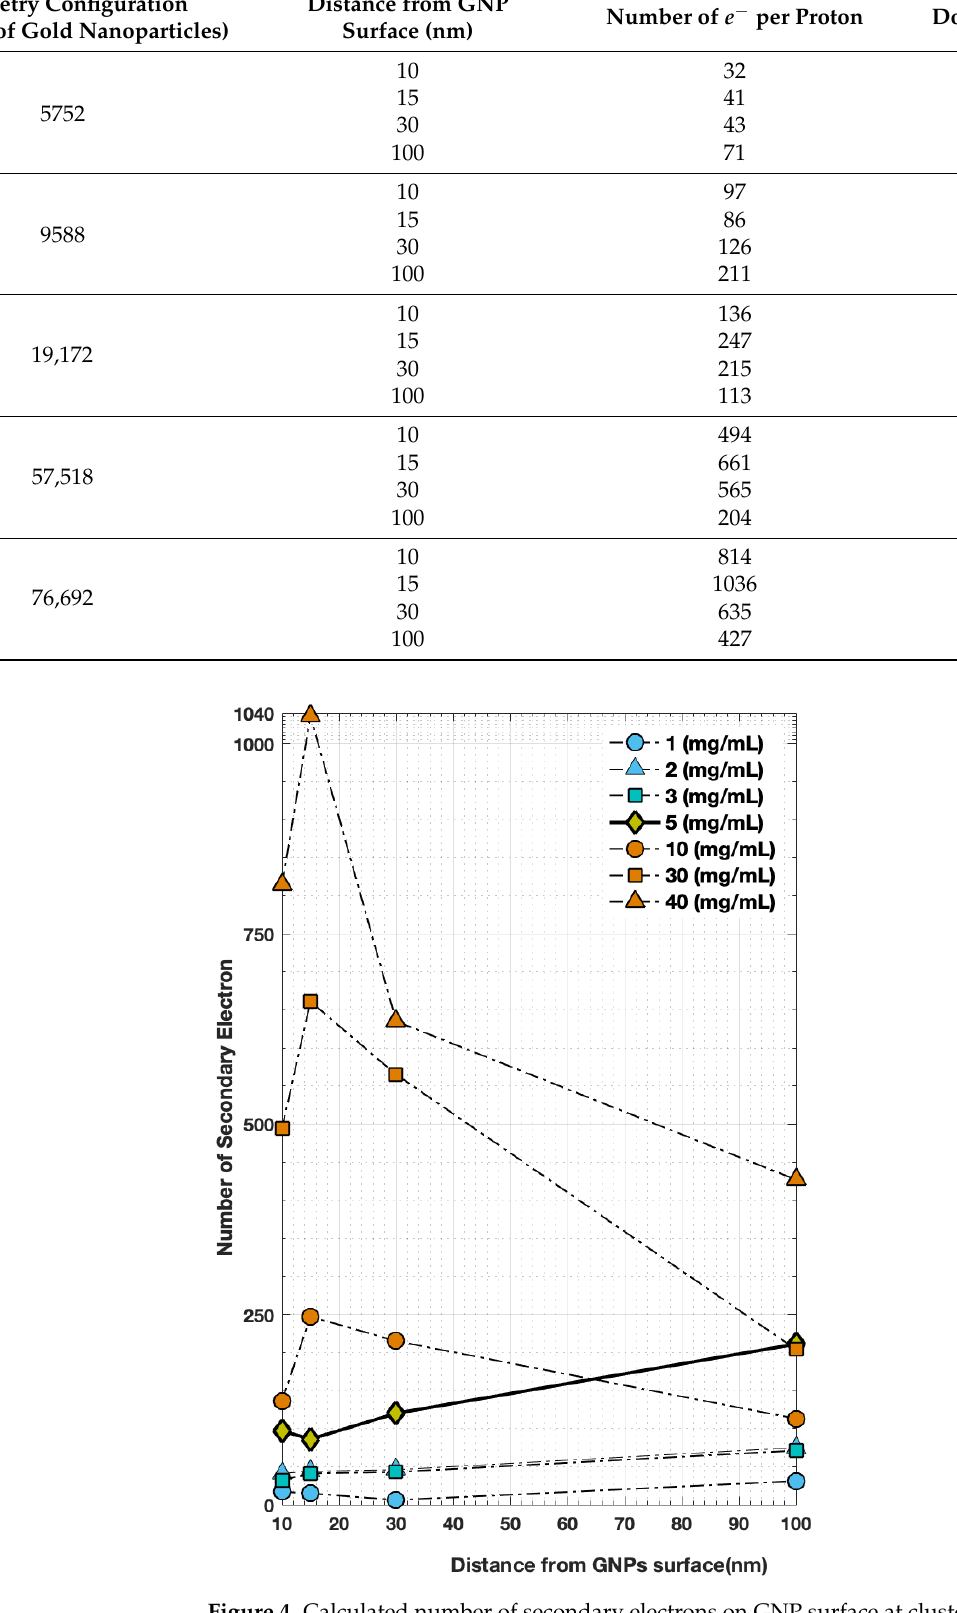
Figure 4. Calculated number of secondary electrons on GNP surface at cluster concentrations of 1, 2, 3, 5, 10, 30, and 40 mg/mL as a function of radial distance. In the case of concentrations of 1, 2, and 3 mg/mL, at a distance of 10 nm from the surface, the numbers of secondary electrons generated were approximately 17, 41, and 32, whereas at a distance of 15 nm, there were 15, 44, and 41; at 30 nm, there were 6, 46, and 43; and at 100 nm, there were 31, 75, and 71. A difference appeared at concentrations of 10, 30, and 40 mg/mL at a distance of 10 nm from the surface, with approximately 136, 494, and 814 secondary electrons generated, respectively, whereas at a distance of 15 nm, there were 247, 661, and 1036; at 30 nm, there were 215, 565, and 635; and at 100 nm, there were 113, 204, and 427, respectively. The largest change in electron generation appeared at concentrations of 10, 30, and 40 mg/mL; more significant changes were detected at the higher concentration, whereas they were relatively weaker compared with the lower con- centrations, as shown in Figure 4. Additional spherical water volume surrounding GNPs with different radii (10, 15, 30, and 100 nm) was added to determine the absorbed radiation dose in gray (Gy). This geometry was particularly useful for isolating the effect of electrons generated from the GNPs without any influence from the surroundings and comparing them to the reference material, which in this case was water. In other words, proton interactions could only take place in the gold or water if we wanted to record the energy deposition caused by second- ary electrons in this particular region. To achieve this, we counted the secondary electrons emitted from each GNP and then compared the results with the previously published values. As the distance from the GNP surface increased, the absorbed dose decreased